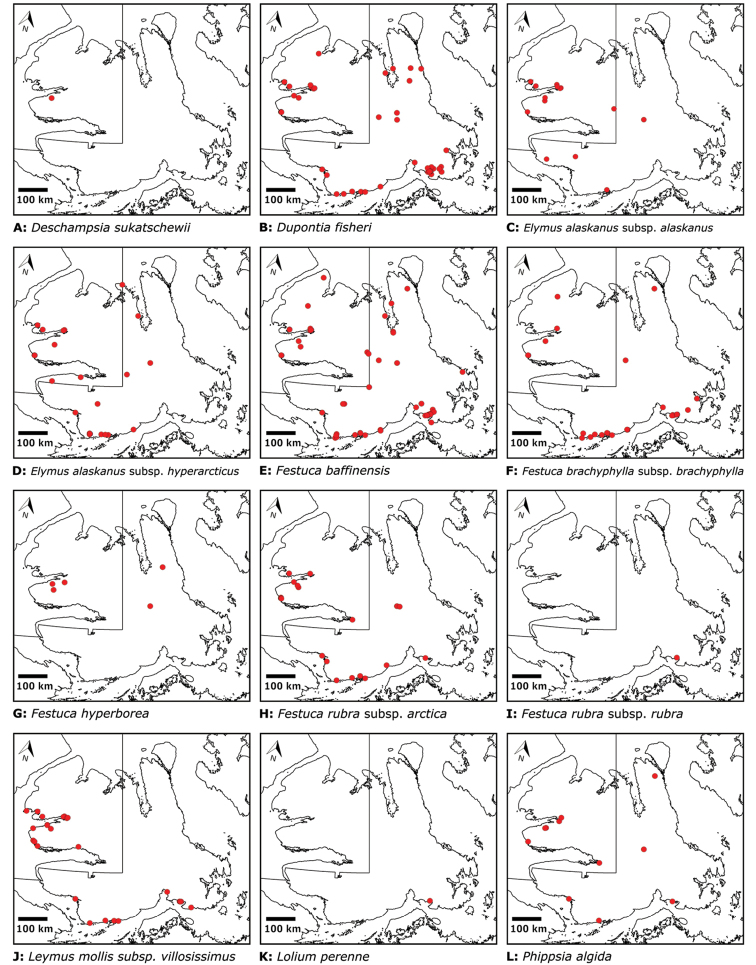
Species distribution maps. Poaceae: ADeschampsia
sukatschewiiBDupontia
fisheriCElymus
alaskanus
subsp.
alaskanusDElymus
alaskanus
subsp.
hyperarcticusEFestuca
baffinensisFFestuca
brachyphylla
subsp.
brachyphyllaGFestuca
hyperboreaHFestuca
rubra
subsp.
arcticaIFestuca
rubra
subsp.
rubraJLeymus
mollis
subsp.
villosissimusKLolium
perenneLPhippsia
algida.